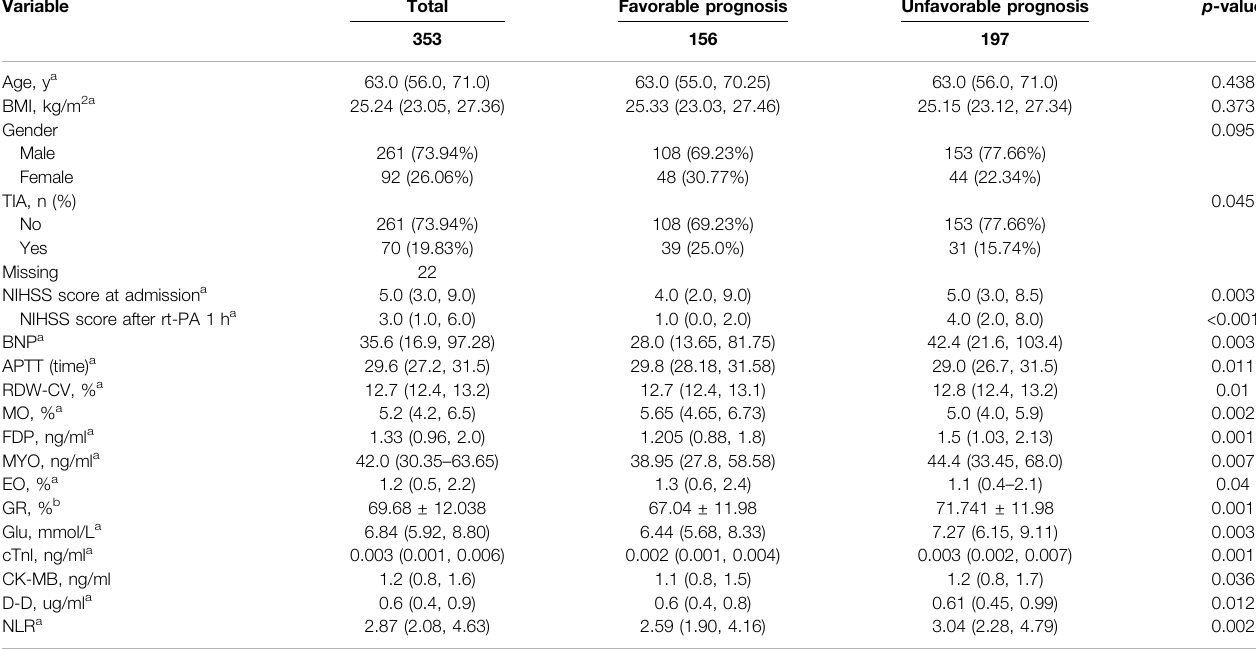
TABLE 1 | Demographic and laboratory data of the AIS patients strati fi ed according to the NIHSS score. Variable